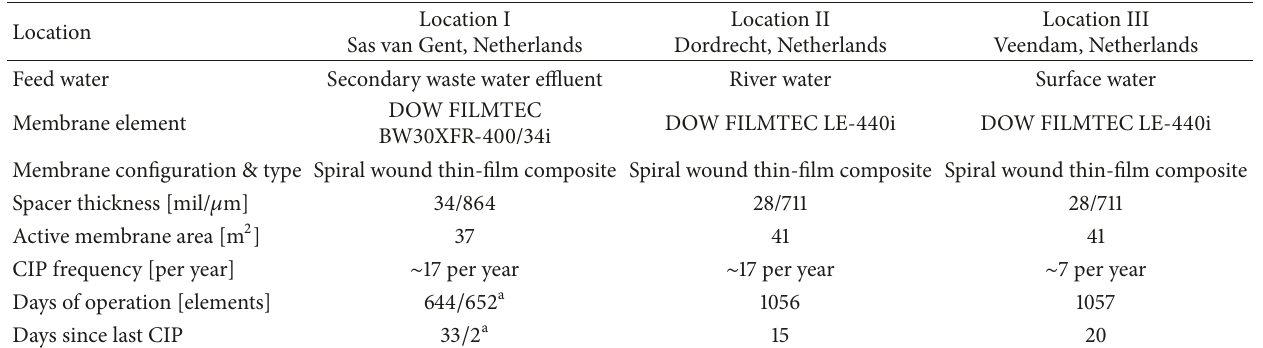
Table 1: Specification and operational history of the membrane elements used in this study.